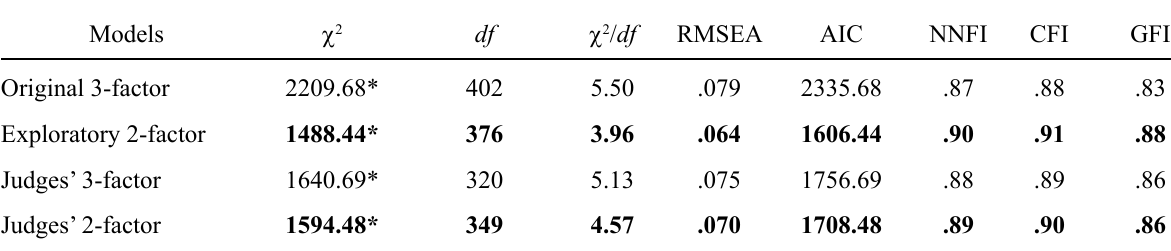
BIS-11 Con fi rmatory Factor Analysis Models